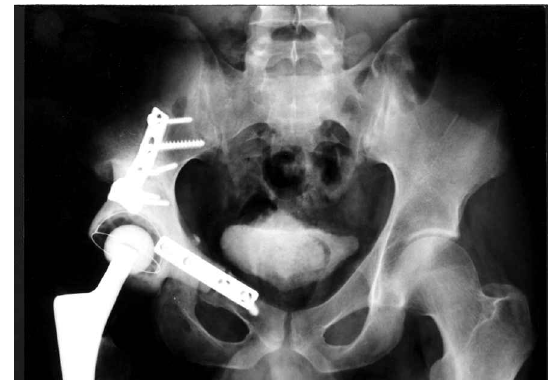
Fig. 3. A 29-year-old man with low-grade chondrosarcoma arising from the right acetabulum; postoperative X-ray after internal hemipelvectomy and restoration of the pelvic girdle by polyacetal pelvic